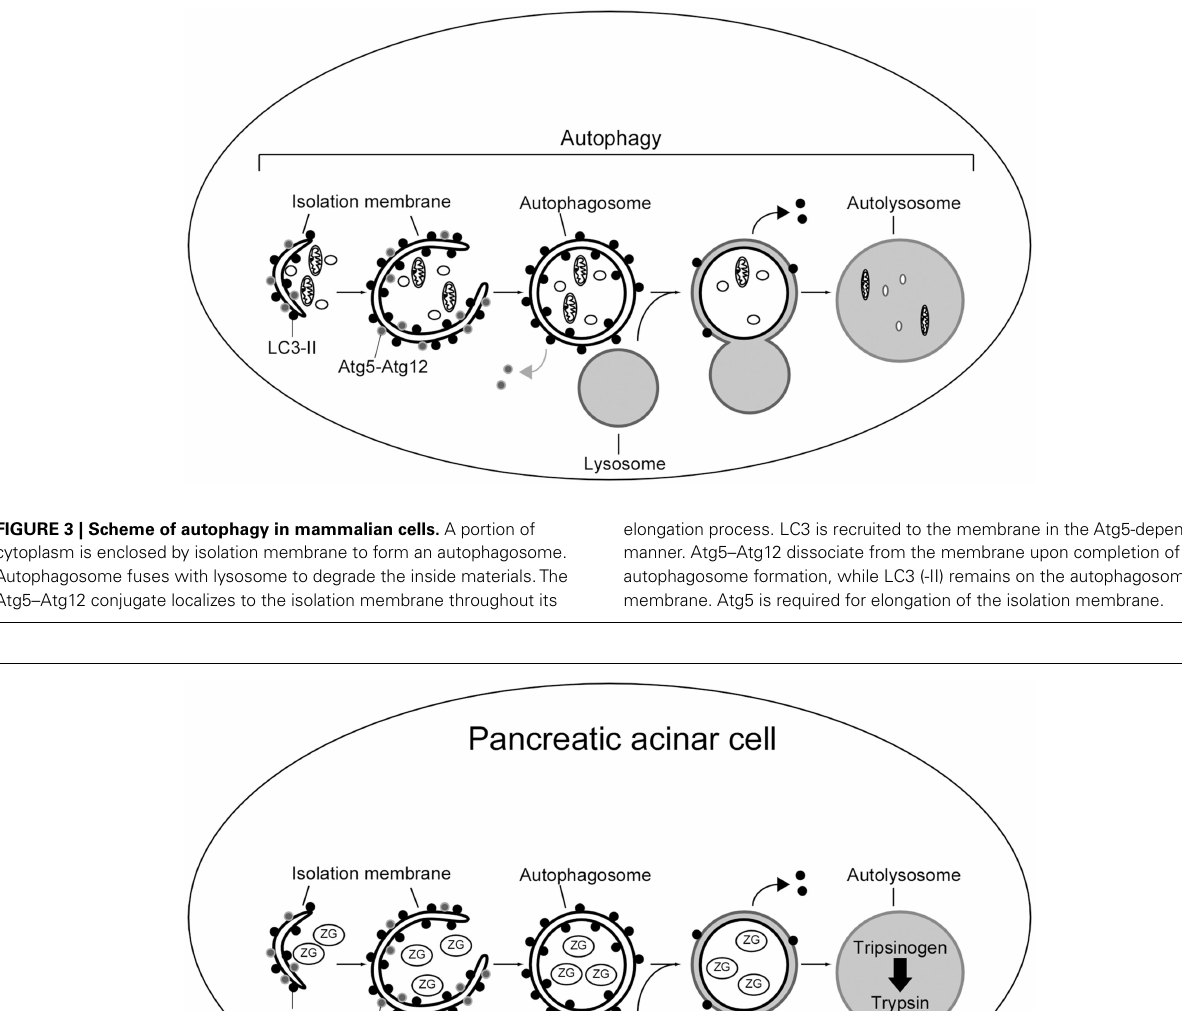
FIGURE 4 | Schematic representation of autophagy within a pancreatic acinar cell in acute pancreatitis. After autophagic vacuole containing zymogen granules fuses lysosome, the trypsinogen is activated by lysosomal hydrolases in autophagic process, and release of activated digestive enzymes inside the